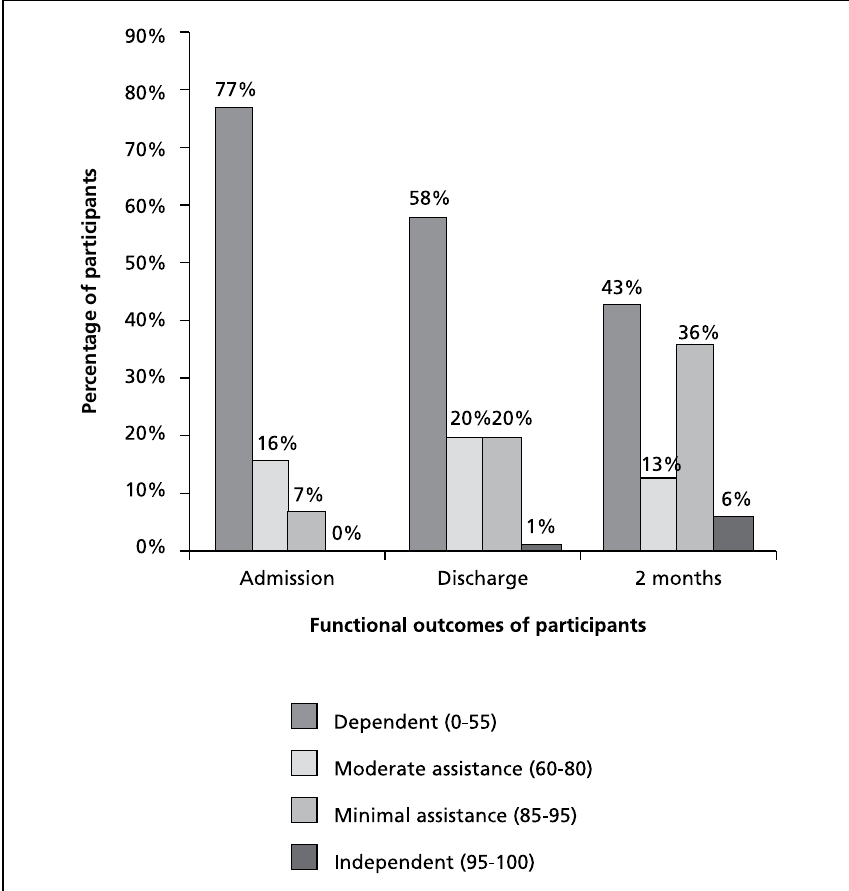
Figure 1: Functional outcome as measured by bi at different assessment periods